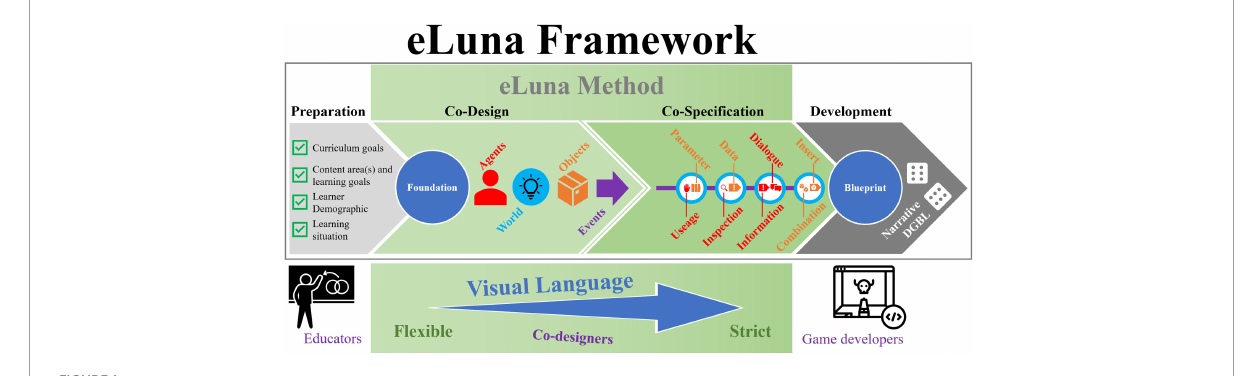
FIGURE1 The eLuna Framework overview (Breien and Wasson,